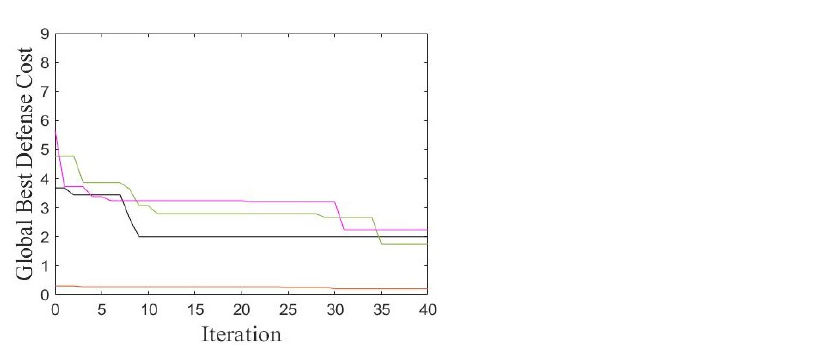
Figure 16. Convergence of defense cost against slant formation with kill probability set to 1, black: ζ 1 , orange: ζ 2 , green: ζ 3 , purple: ζ 4